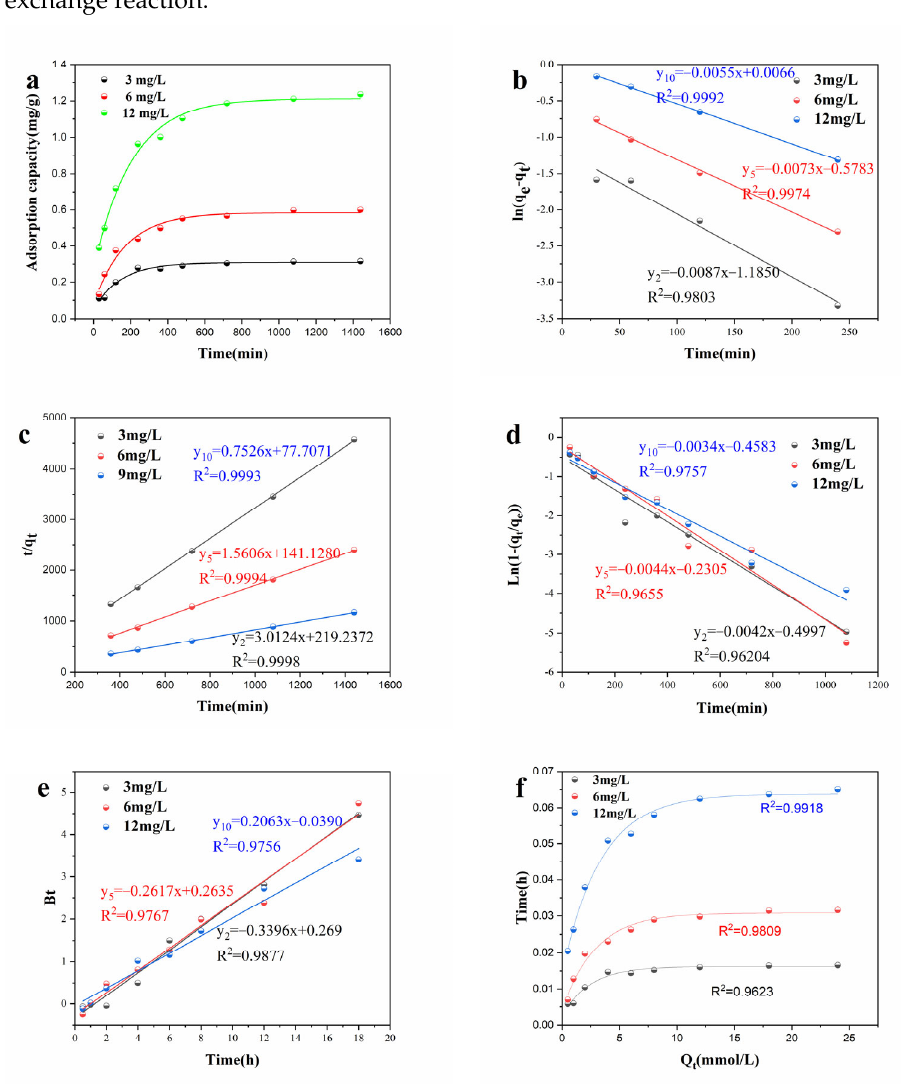
Figure 6. Adsorption kinetic curve on MAA ( a ); adsorption kinetic experimental data at 3 mg/L, 6 mg/L, and 12 mg/L of initial fluoride concentration Kinetic model of quasi ‐ first ‐ order ( b ), quasi ‐ second ‐ order ( c ), film diffusion ( d ), Boyd diffusion ( e ), Langmuir kinetics ( f ) fitting on MAA.